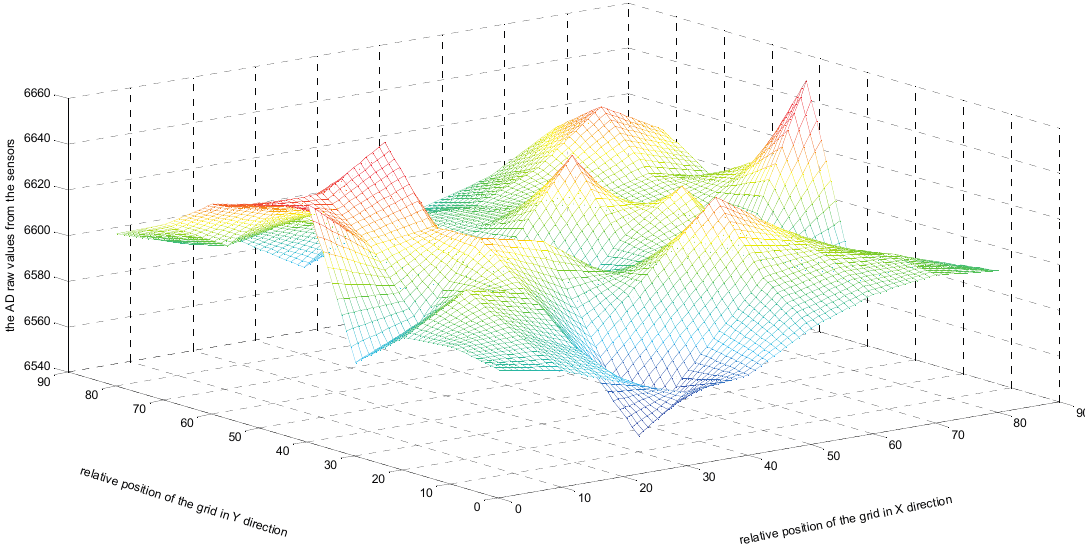
Figure 4. Real monitoring data values displayed in 3D.